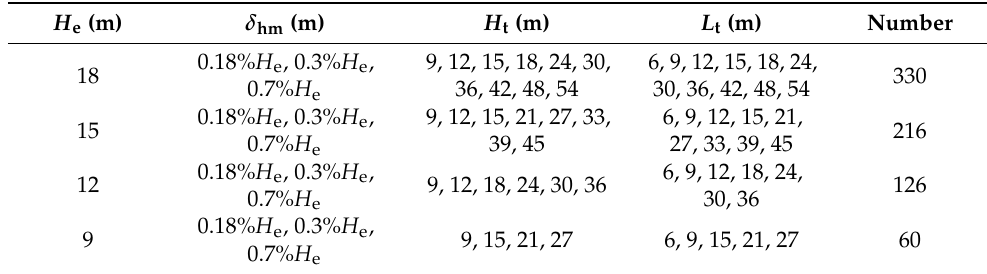
Table 2. Numerical simulation